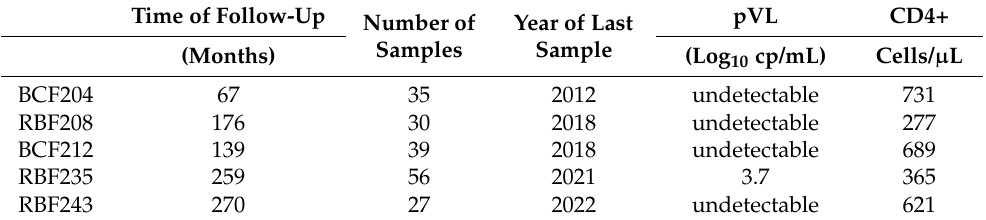
Table 1. Data for the 5 patients infected by an HIV-1/MO with multiple sequential samples.